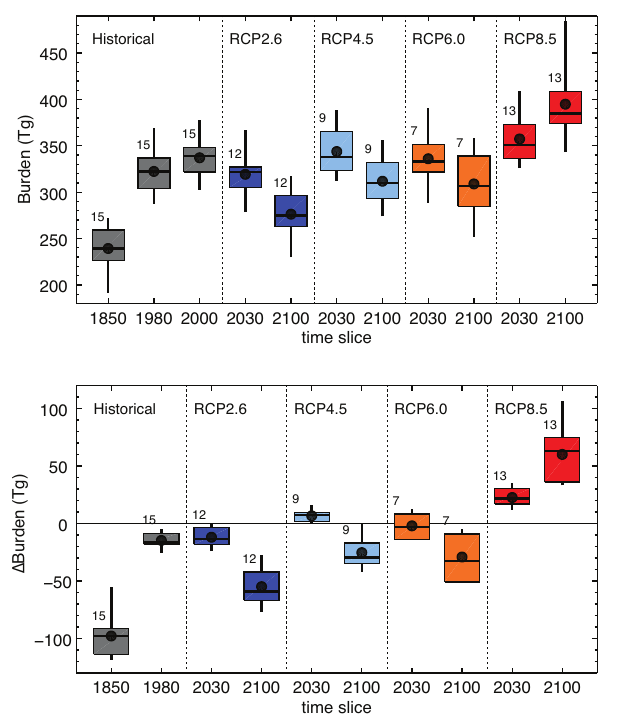
Fig. 7. (a) Modelled tropospheric ozone burdens for the different scenarios and time slices. (b) Change in the tropospheric burden, relative to the Hist 2000 simulation. The box, whiskers, line and dot show the interquartile range, full range, median and mean burdens and differences, and the numbers indicate the number of ACCMIP models with results for a given scenario and time slice, all in a sim- ilar style to Fig.